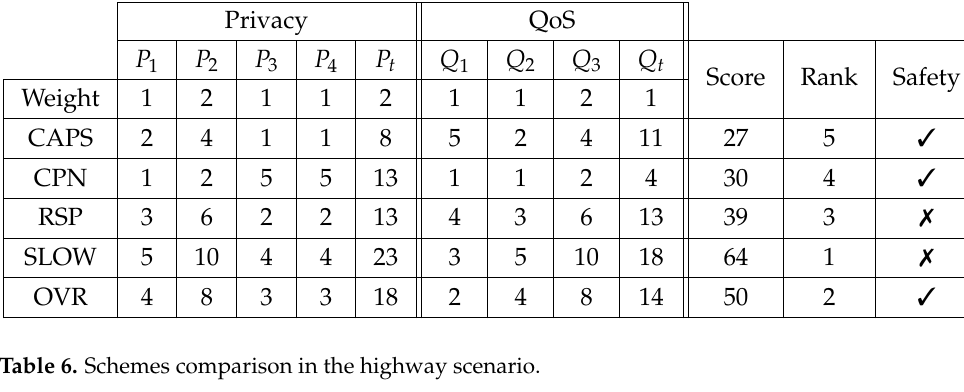
Table 5. Schemes comparison in the Manhattan scenario.